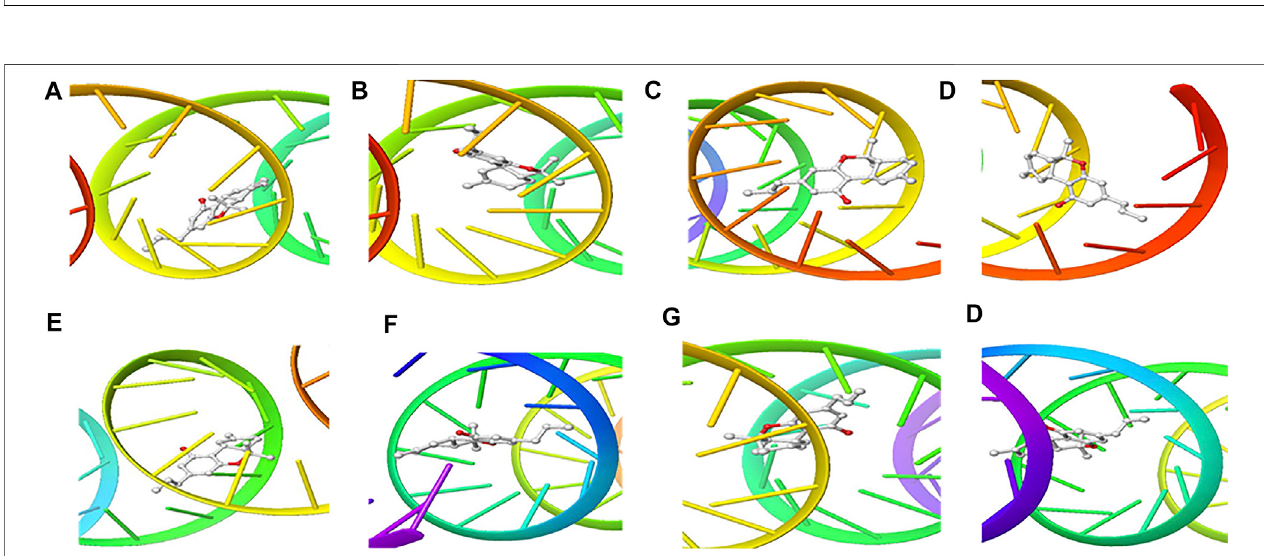
FIGURE 5 | 3D Interaction of tetraydrocannabivarin with Initiation and Termination Sequence of the Viral Proteins. A (cid:1) Nucleocapsid Phosphoprotein Translation Initiation Site; B (cid:1) Envelope Protein Translation Initiation Site; C (cid:1) Envelope Protein Translation Termination Site; D (cid:1) Nucleocapsid Phosphoprotein Translation Termination Site; E (cid:1) ORF1ab Translation Initiation Site; F (cid:1) ORF1ab Translation Termination Site; G (cid:1) Surface Glycoprotein Translation Termination Site; H (cid:1) Surface Glycoprotein Translation Initiation Site.